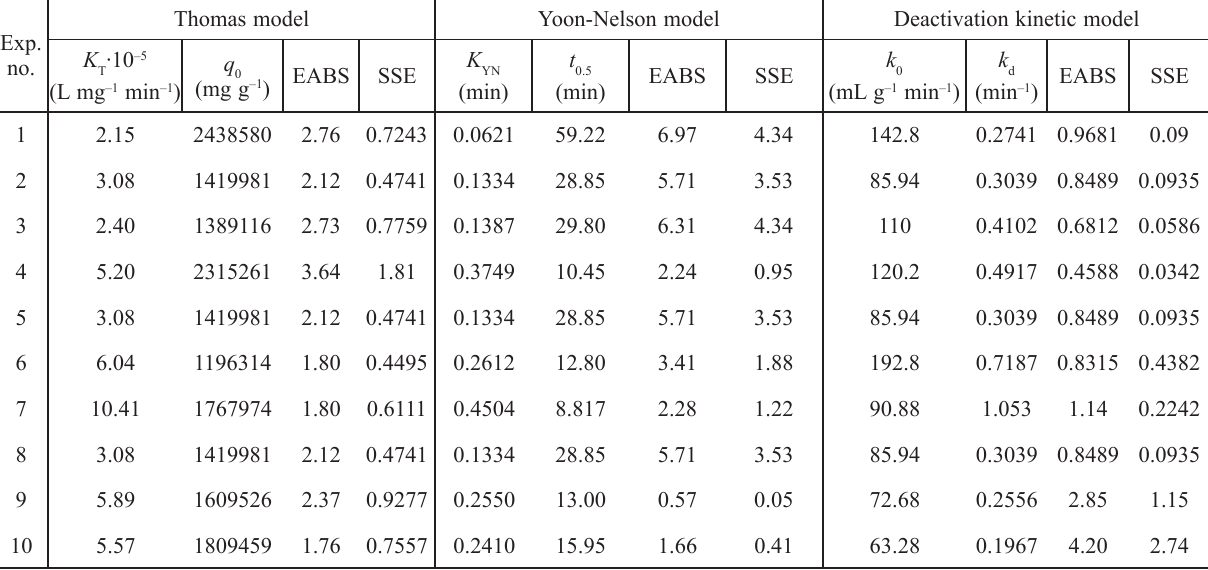
nanoparticles 2